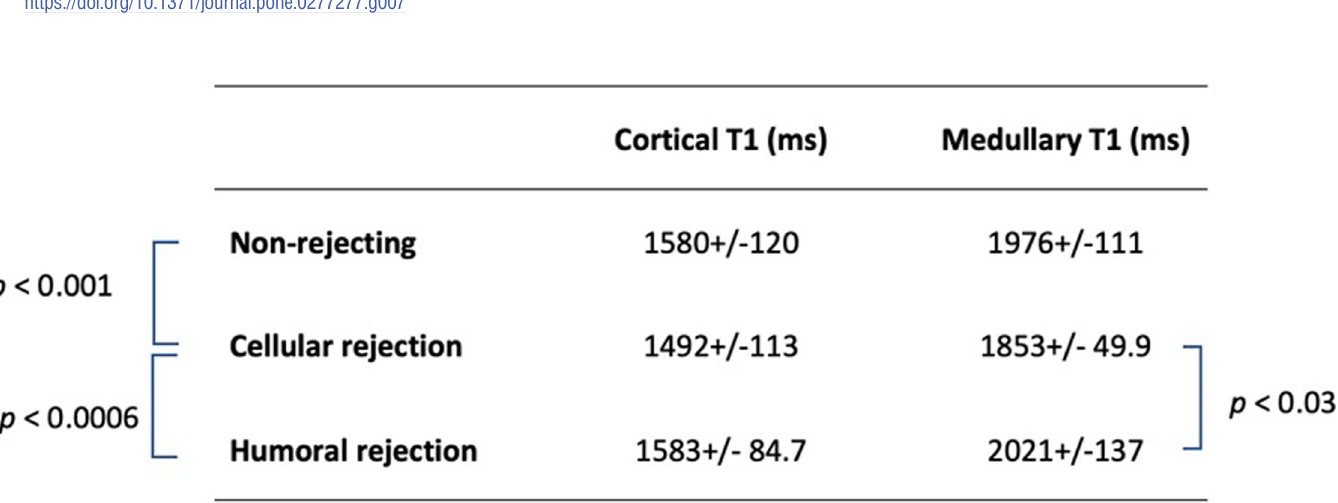
Fig 8. T1 values (mean +/- standard deviation in ms) measured by the automated RCM U-Net method in the cortex and medulla of transplant patients according to their status (no rejection, cellular or humoral rejection) with the corresponding significant p values from the linear mixed models’ analysis.